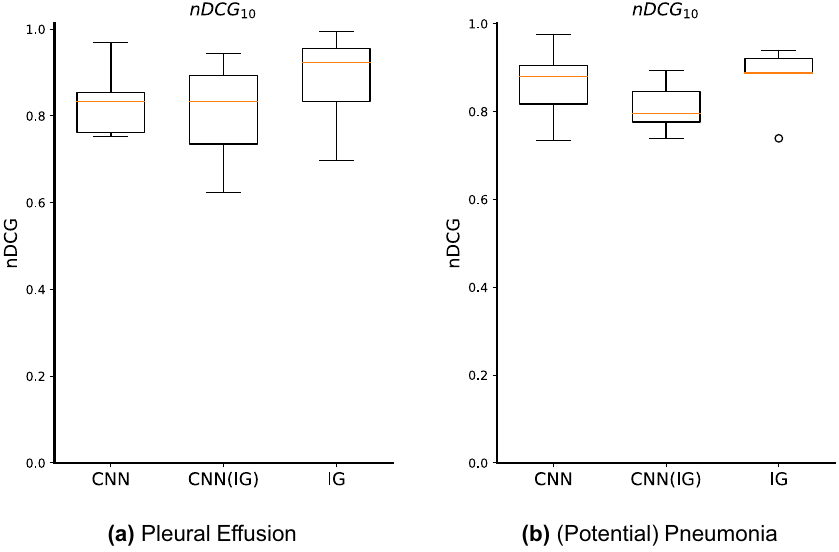
Figure 9. Box-and-whisker plots regarding the nDCG results for Top-10 retrieved images. CNN is the CNN baseline model, CNN(IG) is the CNN model having as inputs the Deep Taylor saliency maps, and IG is the proposed interpretability-based approach (i.e., it was trained (fine-tuned) with saliency maps, and has as inputs also saliency